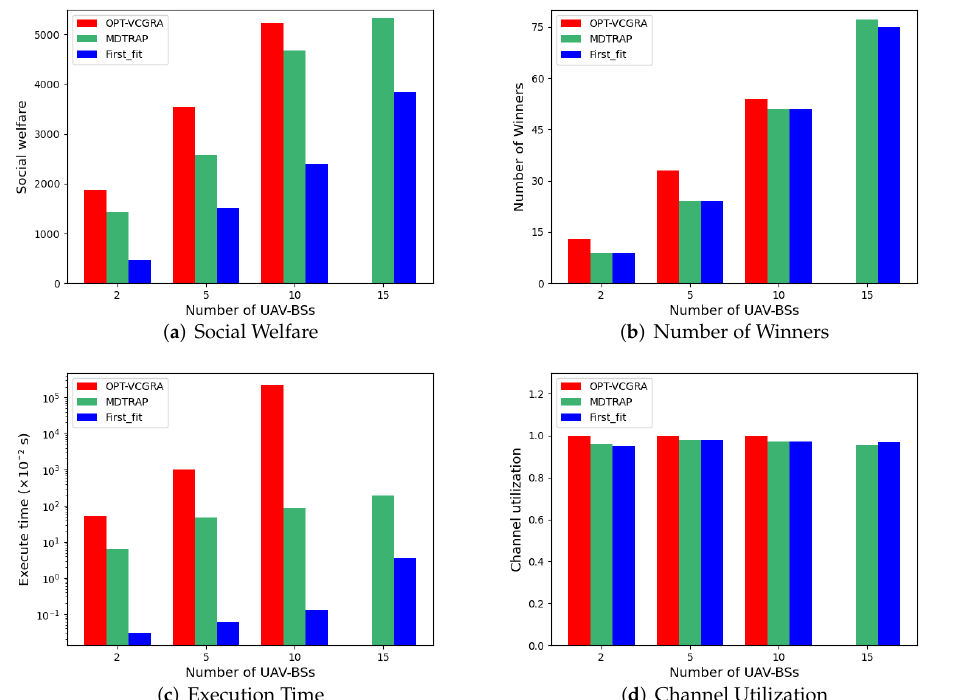
Figure 7. Social welfare, number of winners, execution time and channel utilization under different numbers of